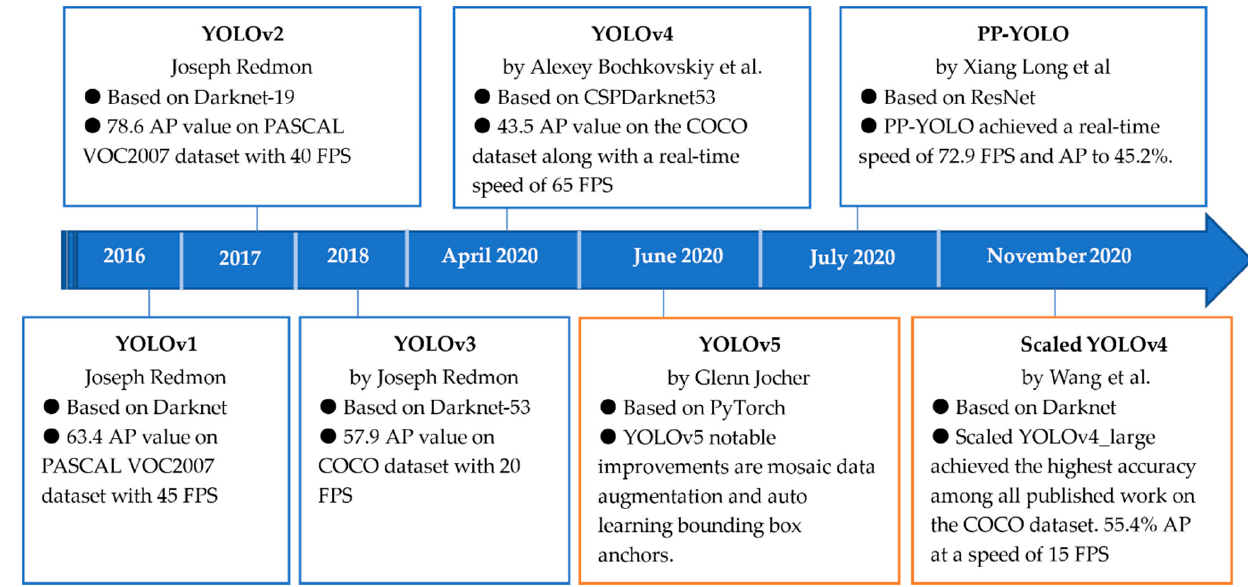
Figure 5. Timeline and performance comparison between members of the YOLO family.